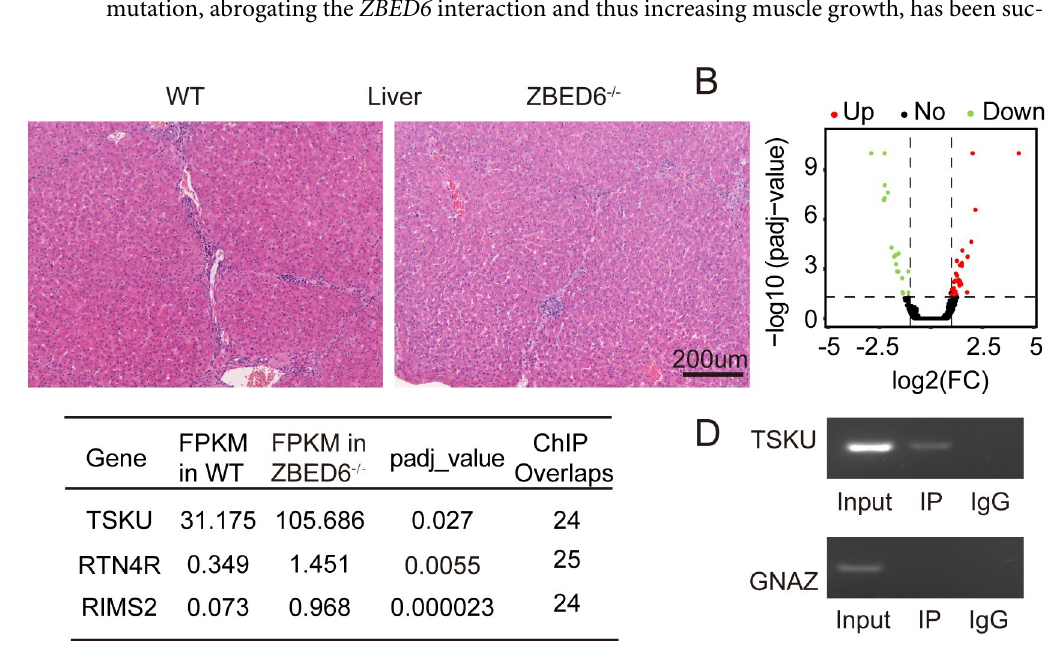
Fig 5. The regulation of ZBED6 in the liver. (n = 3). (A) Haematoxylin and eosin (H&E) staining of the liver for WT and ZBED6 -/- 3-month-old pigs. (B) Volcano plot showing 51 DEGs of liver between WT and ZBED6 - /- . (C) Three ZBED6 targets of liver DEGs. ChIP overlaps = Number of overlapping extended reads. (D) ChIP-PCR analysis in liver of ZBED6 occupancy at the binding sites of TSKU and GNAZ